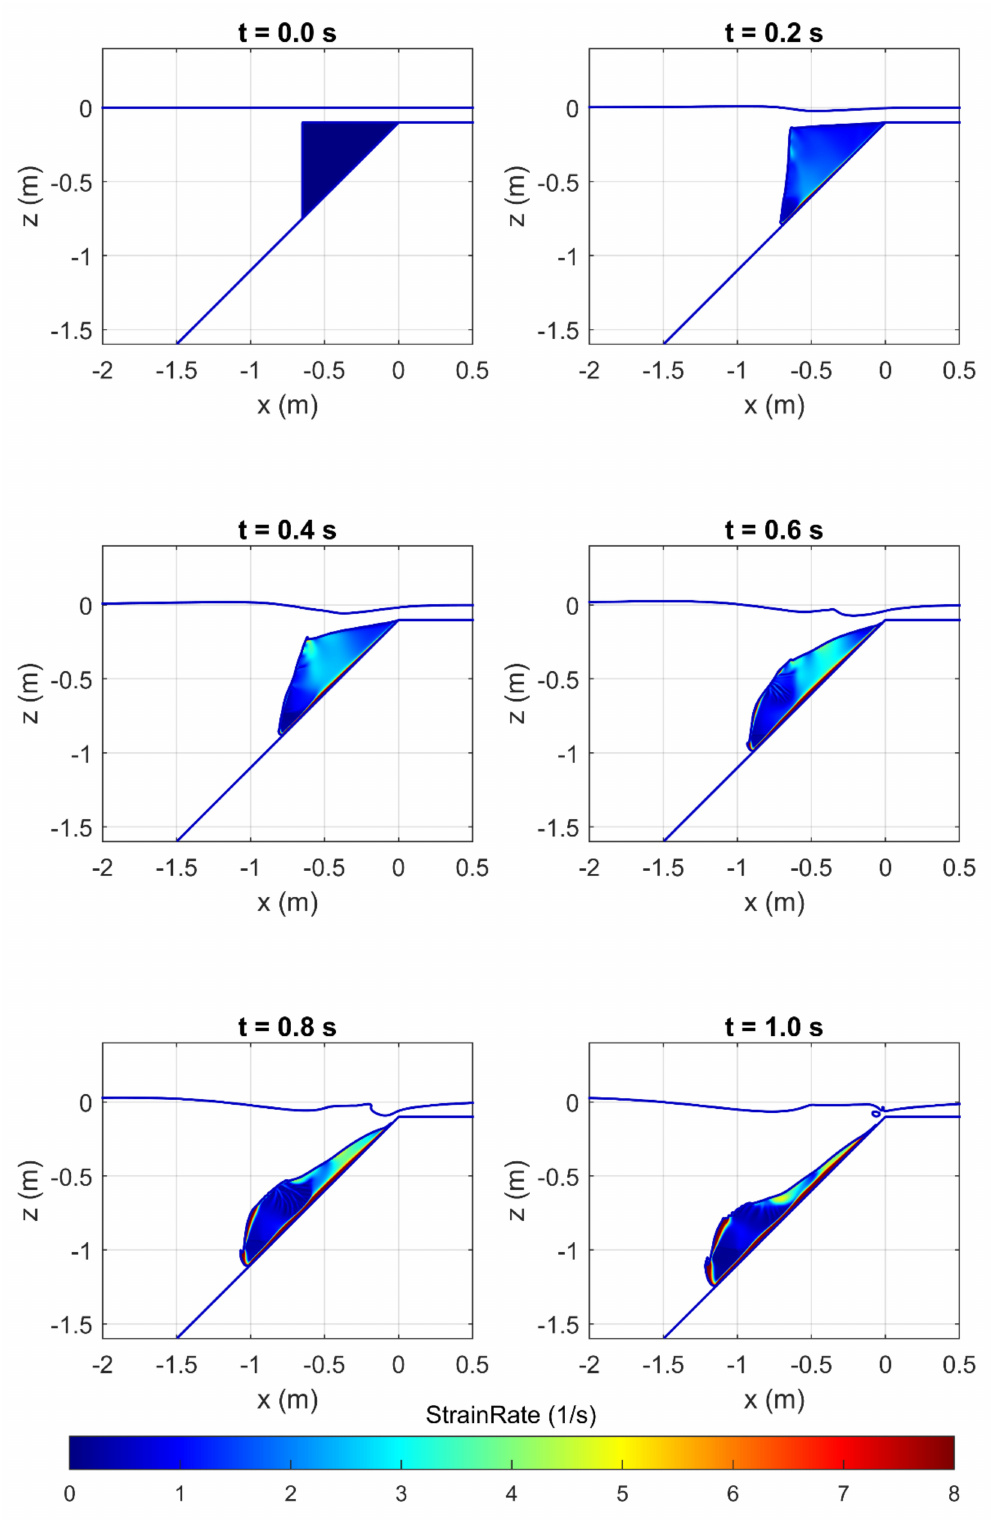
Figure 4. The snapshots of strain rate profiles of the